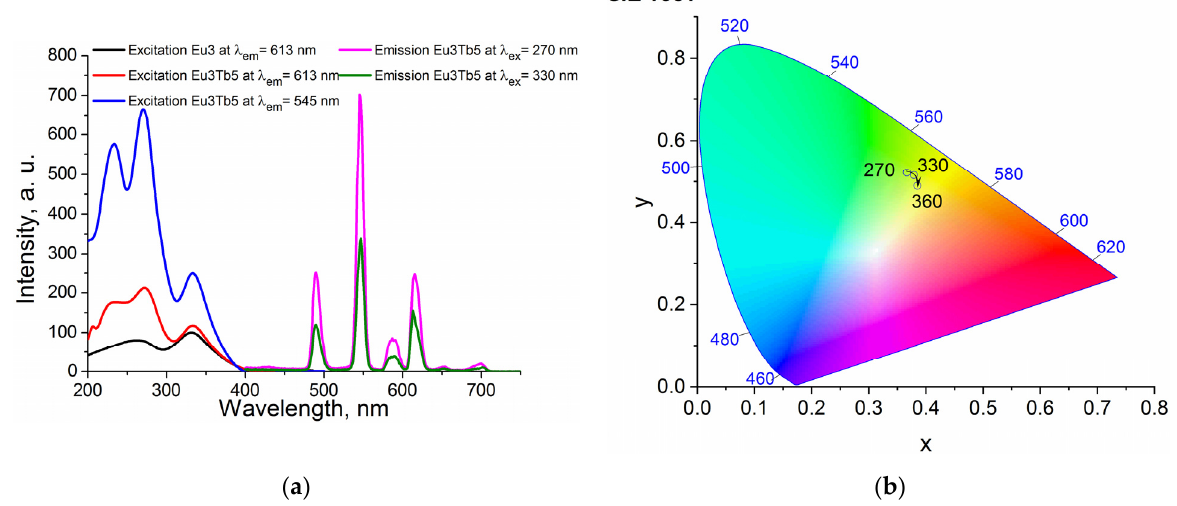
Figure 4. Luminescence spectra ( a ) and the CIE diagram ( b ) of 3%Eu5%Tb at various λ ex .